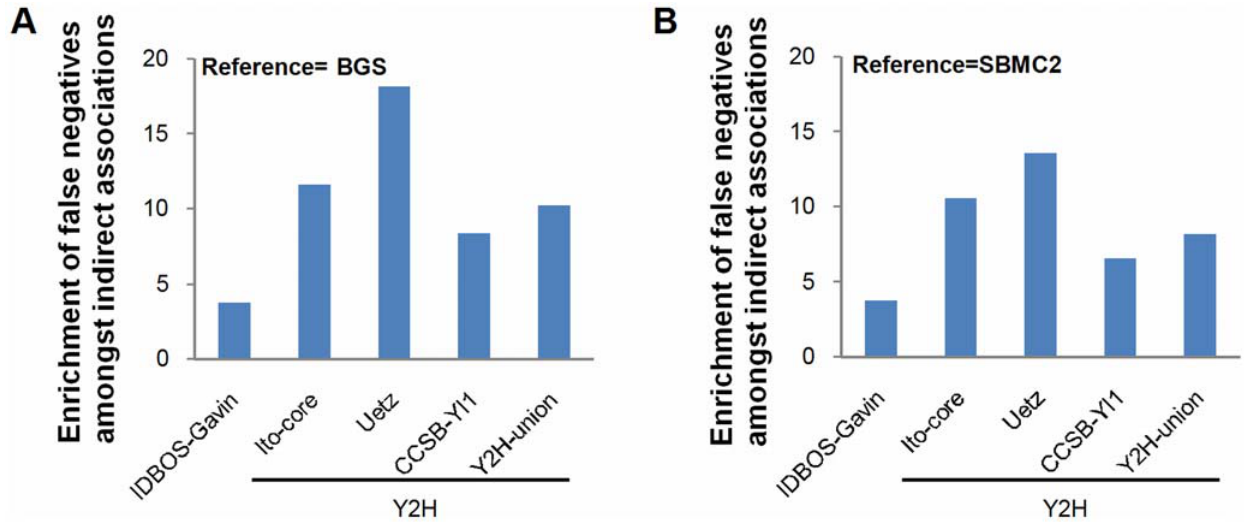
Figure 5. Indirect associations in the IDBOS-Gavin PIN and Y2H data sets are enriched with false negatives. An indirect association occurs when two non-interacting proteins share an interaction partner, e.g., A and B represent an indirect association in the case of A–C–B. Indirect associations form a subset of all non-interactions. A false negative is defined as a non-interaction that is curated as a direct physical interaction in a reference set: (A) BGS, (B) SBMC2 (see Materials and Methods). The fraction of indirect associations that are false negatives (actual) was compared with the fraction of all non-interactions that are false negatives (expected). Enrichments were computed as ratios of actual/expected.